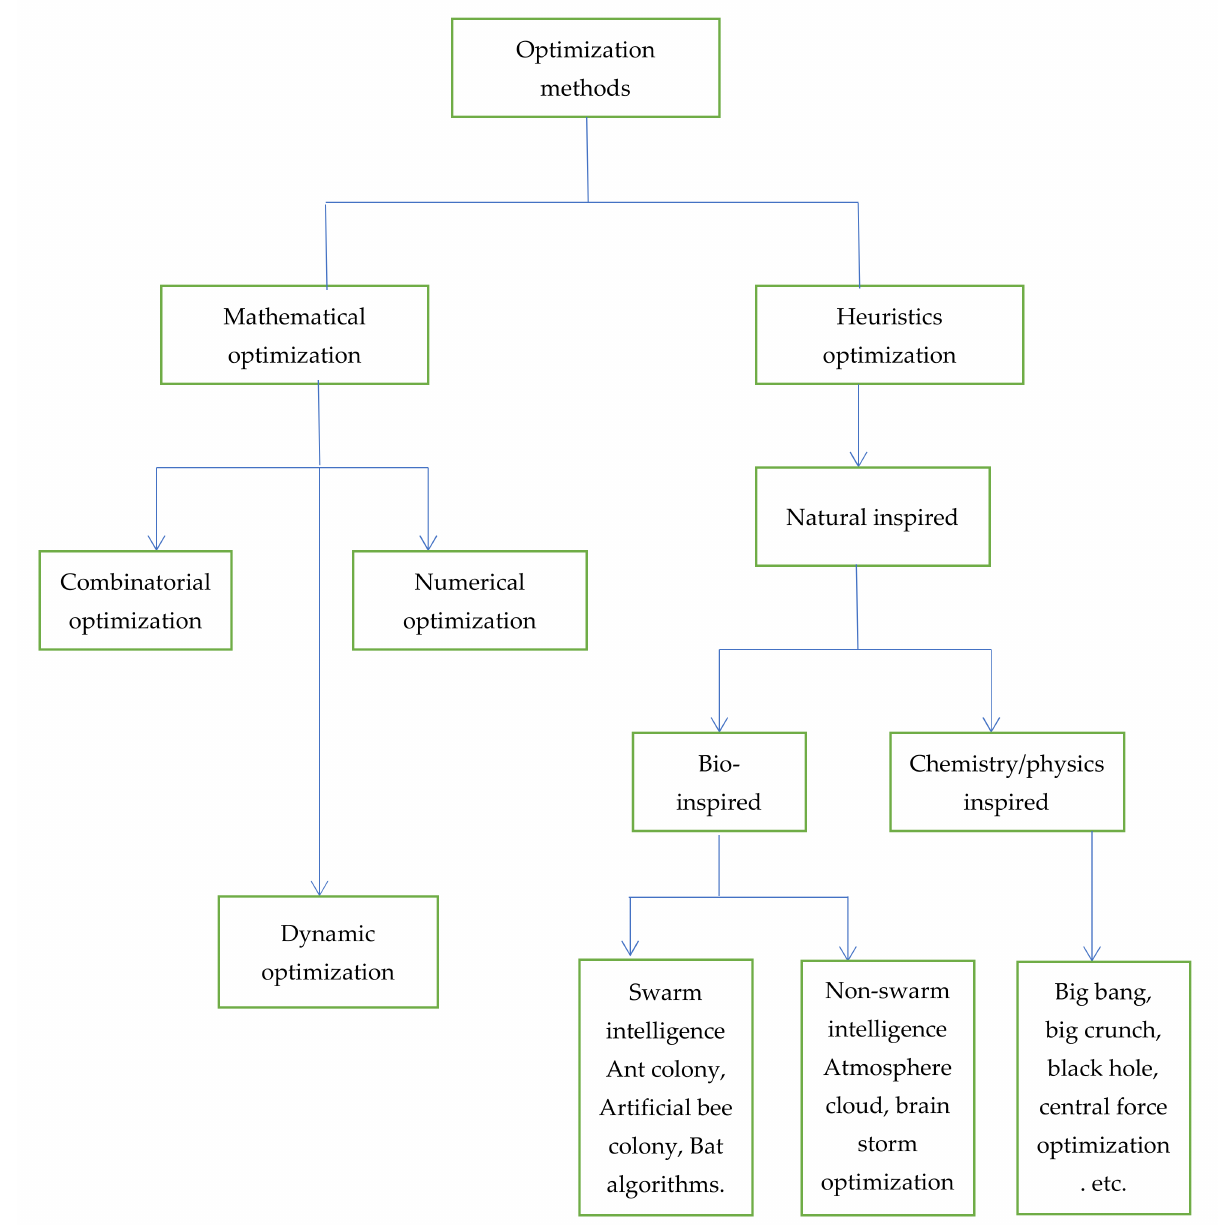
Figure 2. Categories of optimization